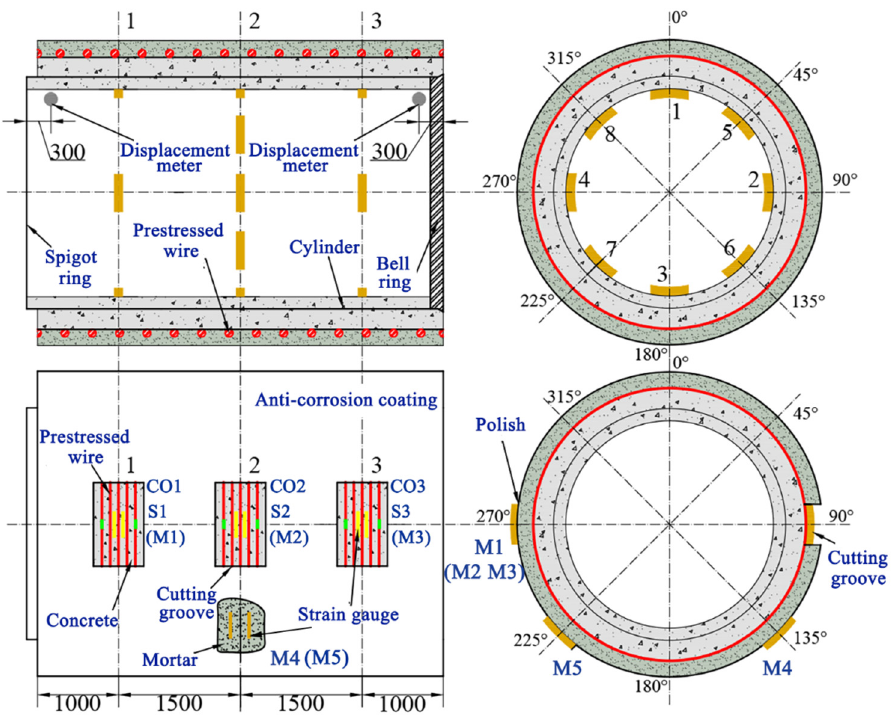
Figure 4. Schematic diagram of monitoring point arrangement (unit: mm).